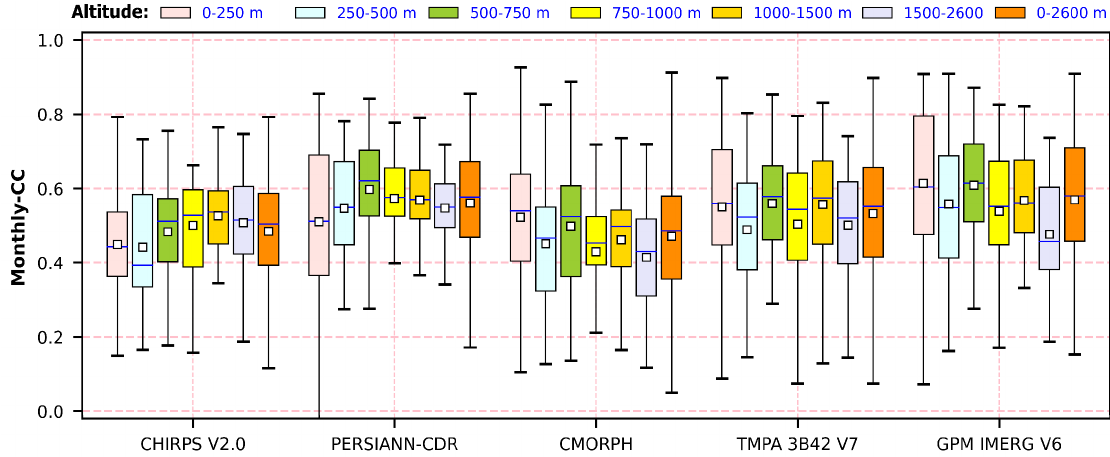
Figure 10. Variation of a monthly correlation coefficient with gauge altitude. Generally, previous studies did not indicate any overwhelming consensus on the best-performing SPDS, where varying recommendations for the same study area were re- ported, depending on the number of used rain gauges, temporal coverage, and selected satellite datasets [56,94,95]. In the current study, CMORPH and GPM IMERG V6 had the best performance indices (quantitatively and categorically) across different regions in the KSA. These results agreed to some extent with the previous research conducted on the KSA by (Sultana, and Nasrollahi, 2017) [44] where CMORPH was recommended and by (Mahmoud et al., 2018) [41] where GPM was recommended for the current study area. Further, the altitudinal assessment of SPDS highlighted the better performance at eleva- tions (500–750 m) compared to lower elevations (0–500) found in coastal areas at moun- tains’ toes, which aggrees with (Kim, and Han, 2021) [53] that geographical features affect the quality of CMORPH data. Lastly, the correlation between daily rainfall measurements and SPDS is lower than the correlation at coarser temporal resolutions (e.g., monthly, sea- sonal, and yearly), as concluded by other previous studies [53,55,57]. Table 6. Variation of RMSEc values for each region in the study area (mm).